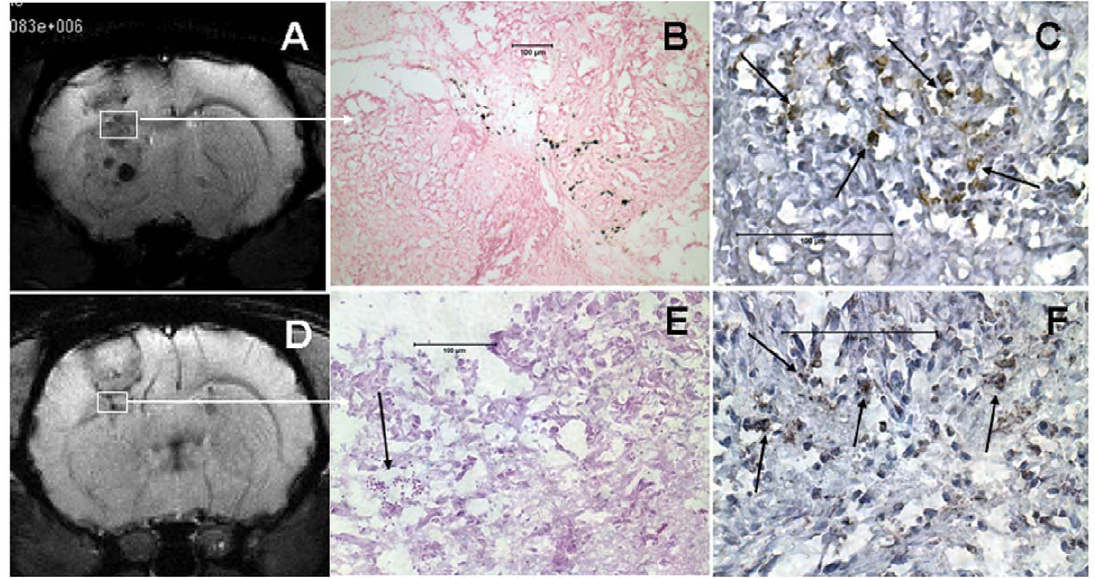
Figure 5. MRI and activated T-cells in tumors. Representative cases of animals that received labeled CTL (A-C) and unlabeled CTL (D-F). (A) T2*- weighted images (T2*WI) showed low signal intensity areas all over the tumors (both periphery and center). (B) DAB enhanced Prussian blue staining showed multiple Prussian blue positive cells corresponding to boxed area (brown spots). (C) Multiple CD45RO positive cells (arrows, activated T-cells) were seen at the corresponding area. (D) T2*WI showed well developed tumor with areas of low signal intensity at the periphery. There were no Prussian blue positive cells seen at the corresponding areas (E), however, multiple hemorrhagic areas were observed (arrow on E). (F) Multiple CD45RO positive cells seen in the tumor. Scale bar =100 m m.